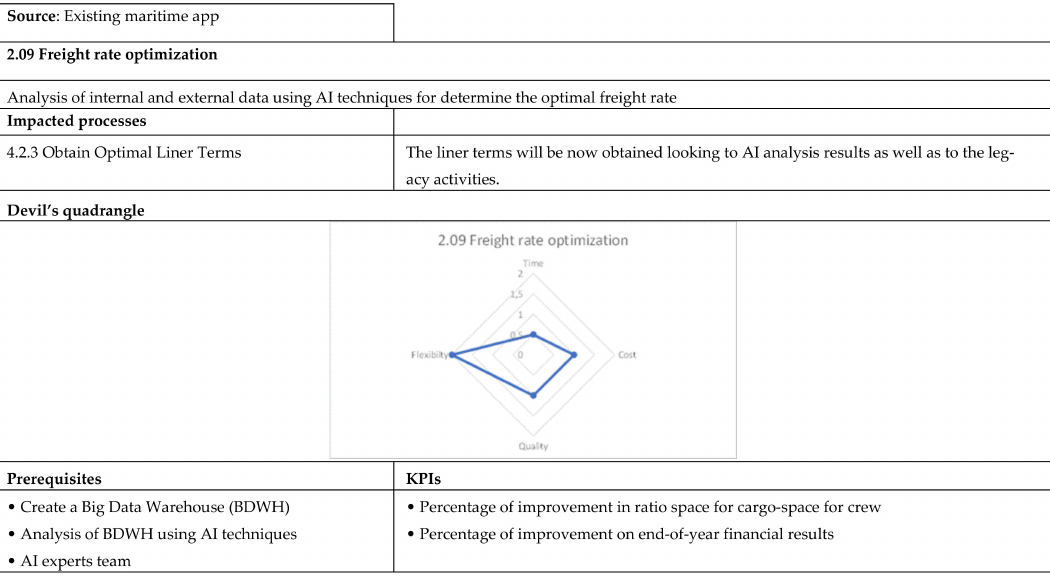
Figure A13. Freight rate optimization data